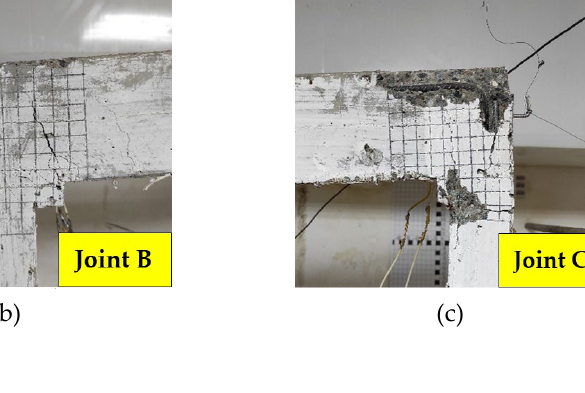
Figure 11. Video processing data for deformation and failure of the test frame under the corner column removal scenario.